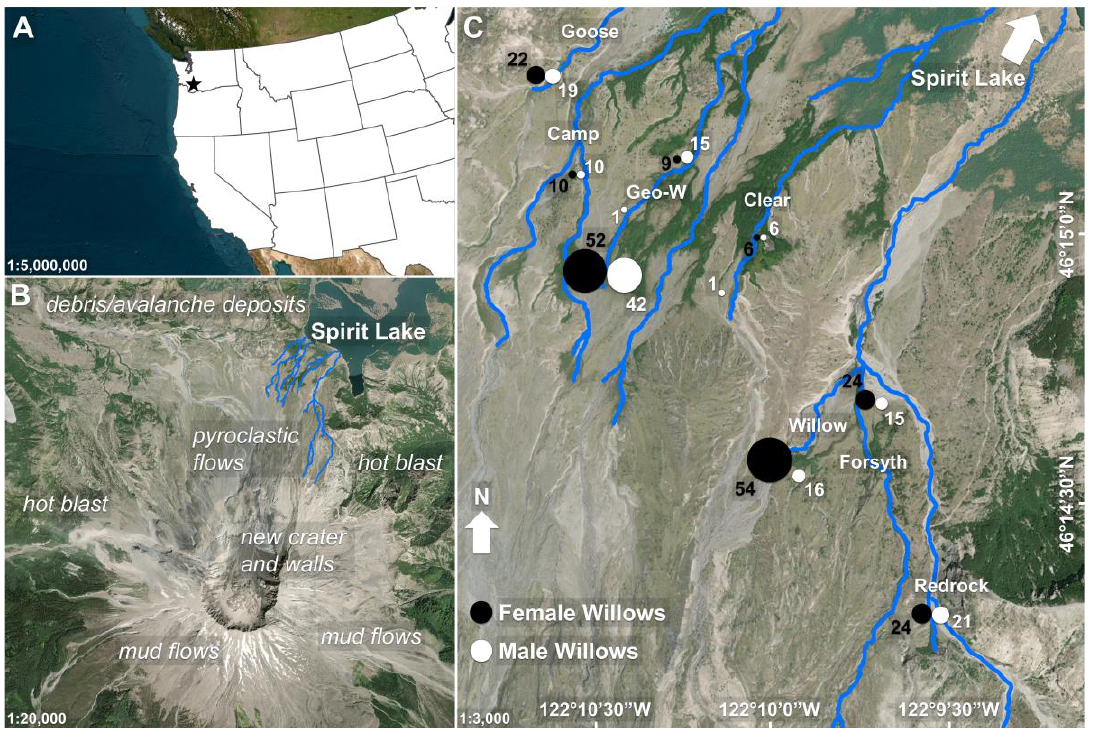
Figure 1. Site and study descriptions for the Pumice Plain of Mount St. Helens. ( A ) Location of Mount St. Helens in Washington State, USA, represented by the black star. ( B ) Dominant geomorphological processes structure landscape processes post-eruption [92]. Blue lines are stream features on the Pumice Plain, near which willow shrubs were sampled. ( C ) Sampling locations of willow shrubs across the Pumice Plain. The sampling of female v. male willows was uneven due to uneven field access and sampling of the most available shrubs. The nearest streams to sampling locations are labeled (Goose, Camp, Geo-W, Clear, Willow, Forsyth, and Redrock). For analyses, Forsyth and Redrock Creeks were separate from Willow Creek, even though they are tributaries. The Circles in Pane C are relative locations with sizes based on the number of samples collected near each stream. The sampling depiction is intentionally simplified here to avoid overlapping objects, whereas the reality of our sampling methods included sampling discrete willow shrubs in upland locations associated with their nearest streams rather than in clusters to capture variability based on the Pumice Plain’s heterogeneous landscape. Projection: WGS 84/UTM Zone 10N. Figure created in ArcGIS Pro (version 3.0.0) [93].